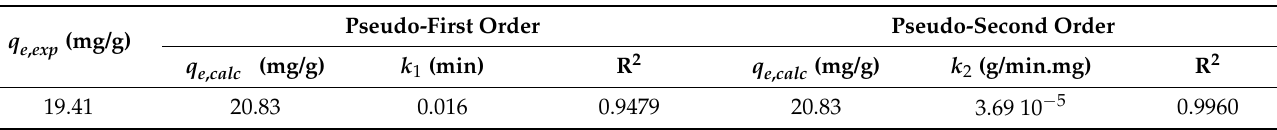
Table 6. Details of the kinetic models during the adsorption of methylene blue on the crystalline